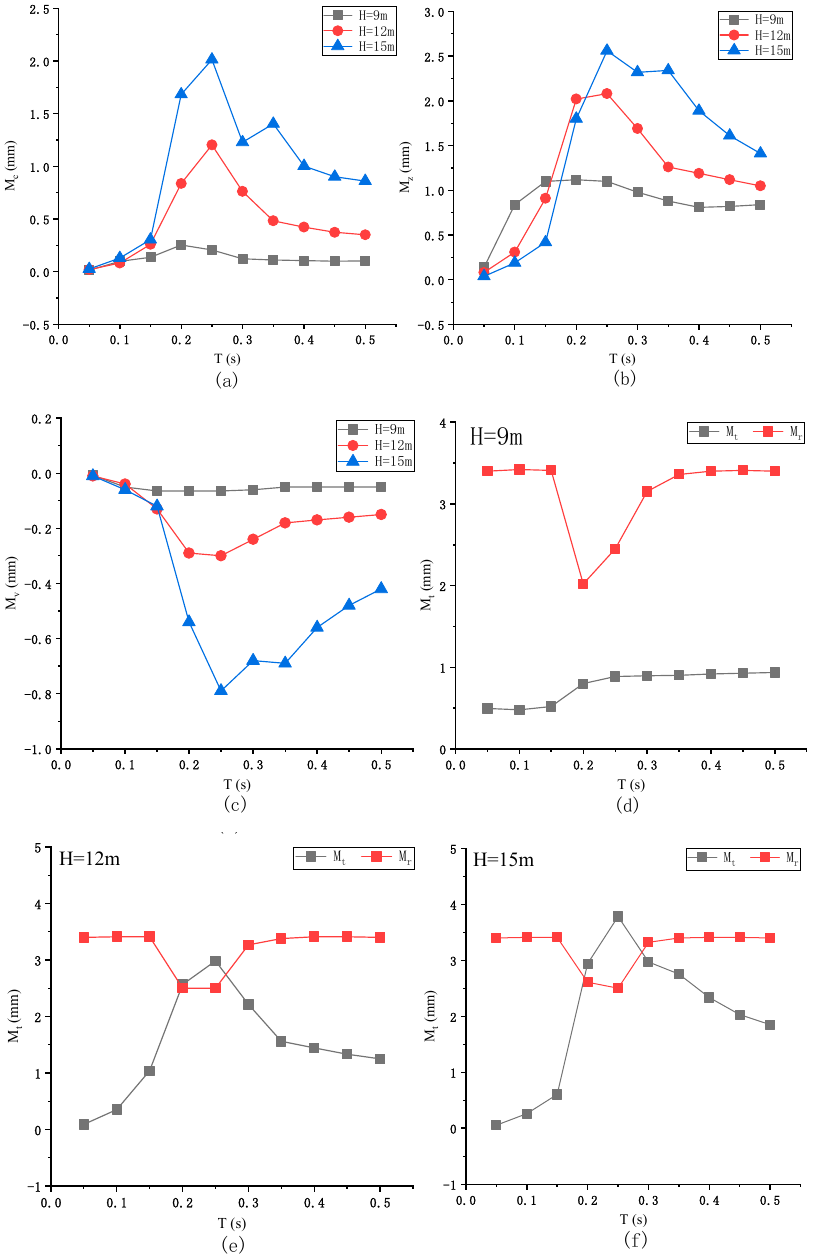
Figure 11. Various bending moments at the bottom of the pier under different periods: ( a ) Bending moment caused by eccentric collision under different excitation periods; ( b ) Bending moment generated by forced vibration under different excitation periods; ( c ) Bending moment caused by bearing shear under different excitation periods; ( d ) When H = 9 m full moment and the permissible moment pier; ( e ) When H = 12 m full moment and the permissible moment pier; ( f ) When H = 15 m full moment and the permissible moment pier;.